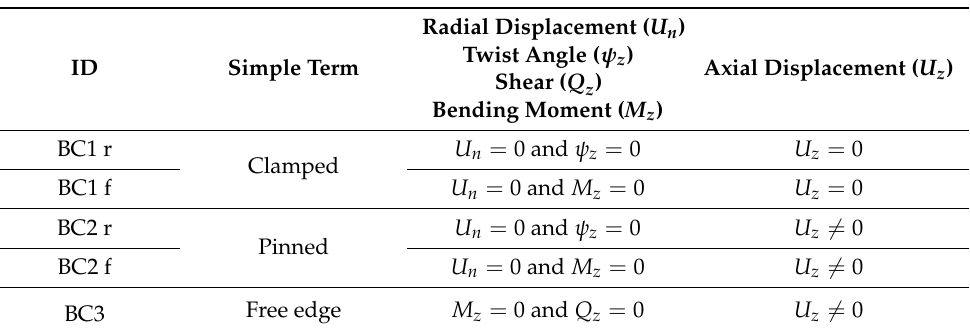
(cid:16) (cid:17) h R